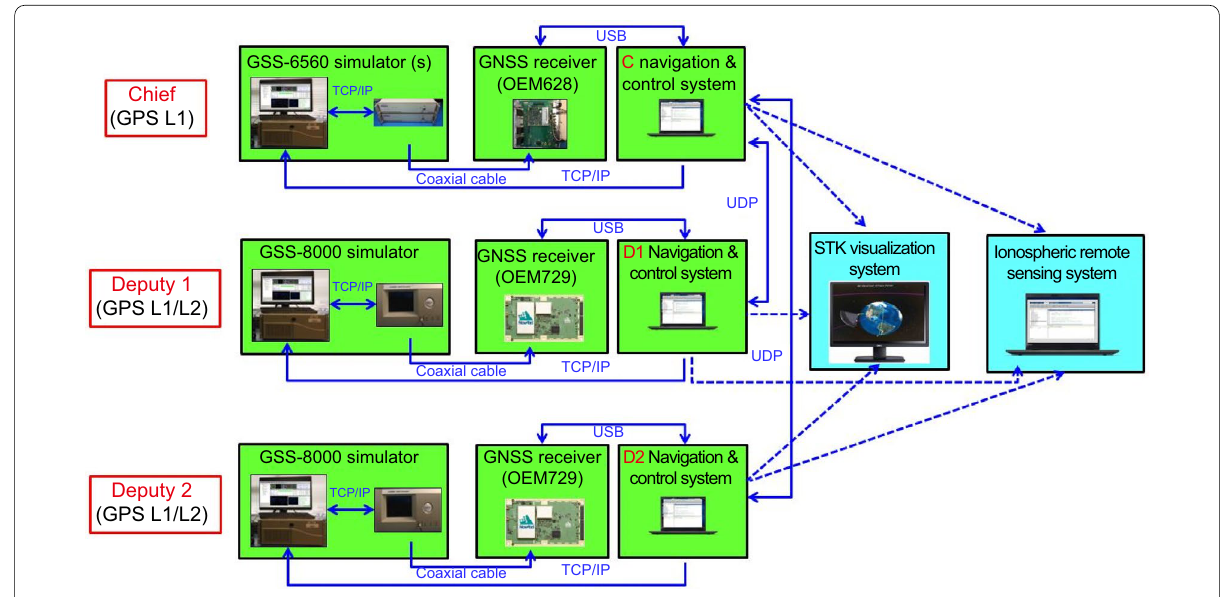
Fig. 15 3-satellite version VTFFTB infrastructure. (Adapted from Peng et al.